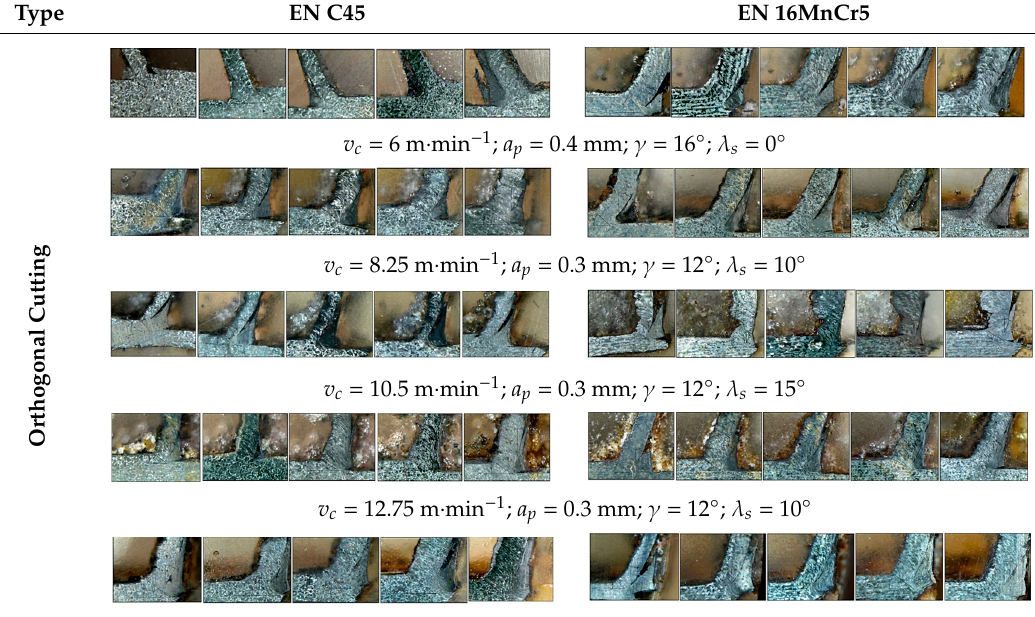
Figure 25. The dependence of shear angle Φ on rake angle γ and angle of tool cutting edge inclination